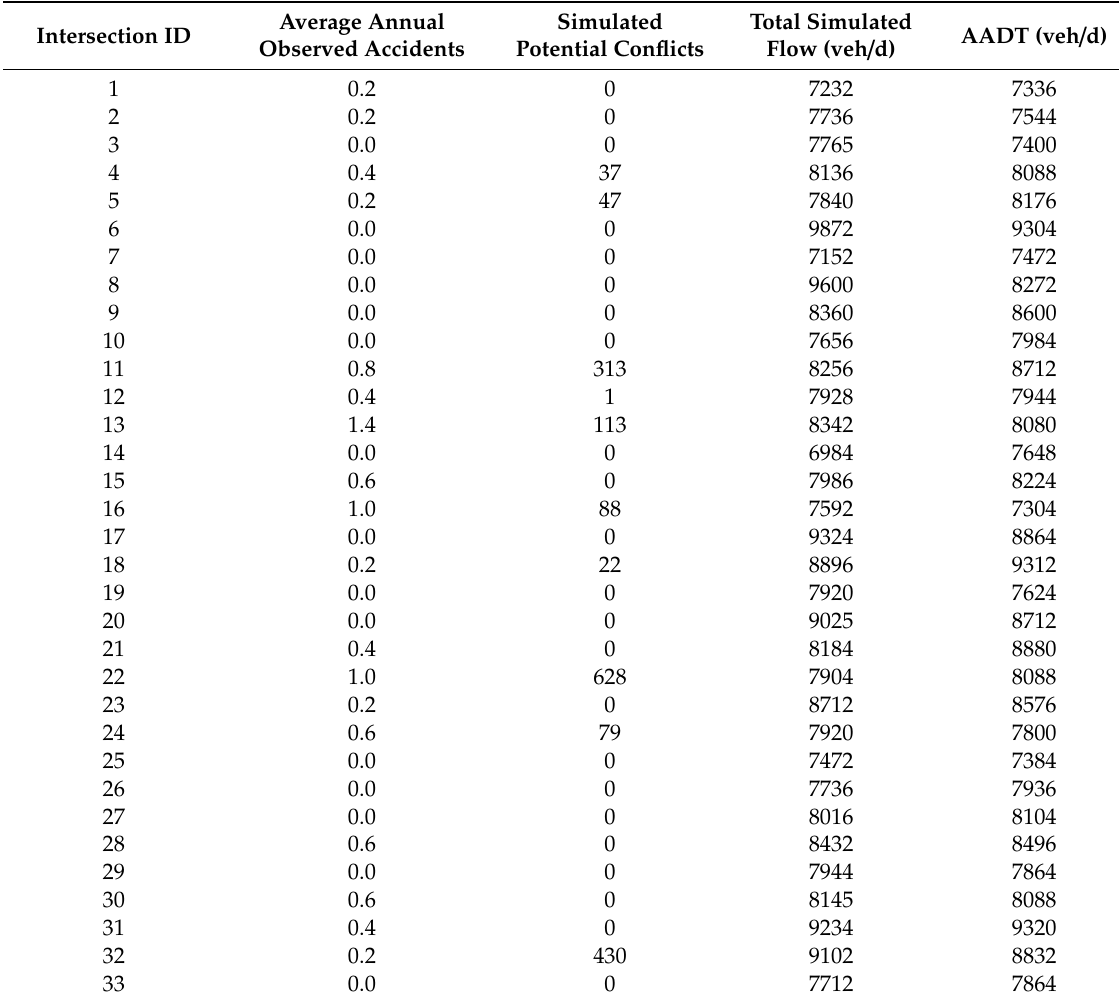
Table 1. Dataset used for the correlation analysis between Accident Rate and Risk Rate. Intersection